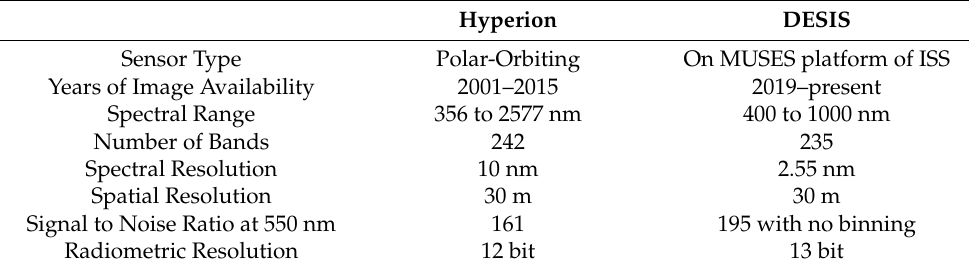
Table 1. Comparison of Hyperion and DESIS sensor